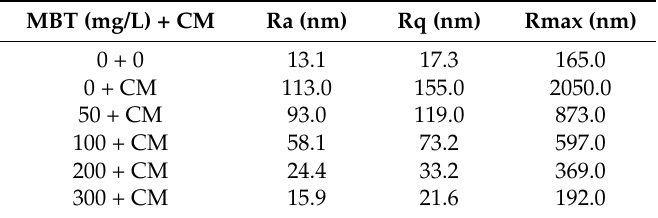
Table 5. AFM parameters after soaking in different concentrations of corrosion inhibitor